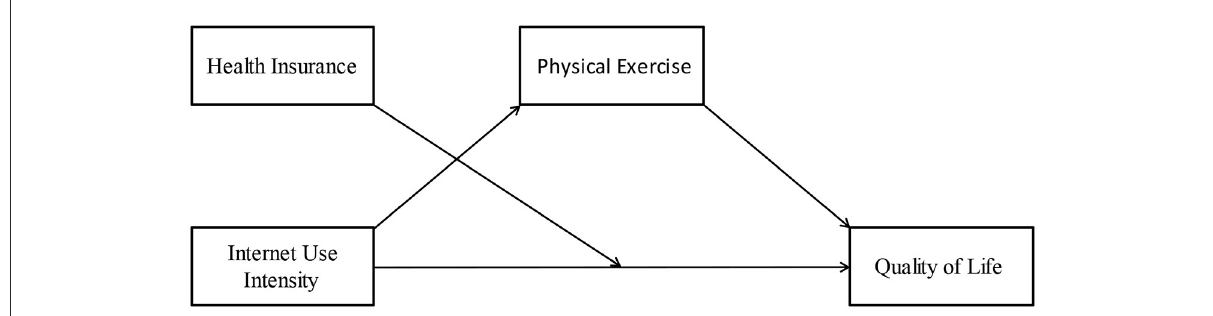
FIGURE1 The relationship among internet use intensity, quality of life, physical exercise, and health insurance.